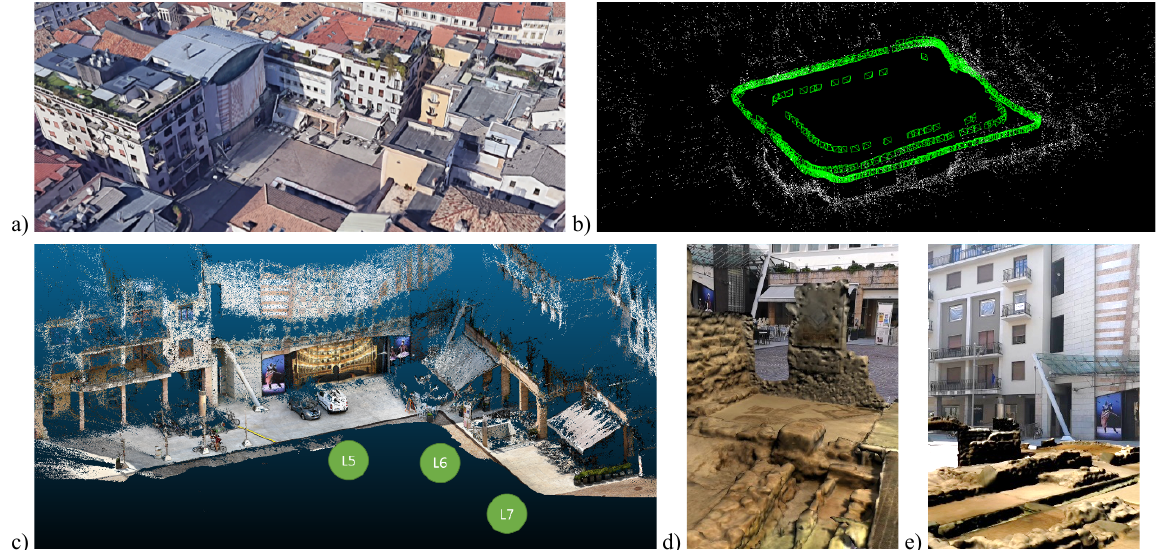
Figure 6 . The square above the Roman city in Trento as seen in Google Earth (a) and the sparse reconstruction from smartphone video sequences (b). Part of the dense point cloud of the area and the positions L i for the localization tests (c). Some views of the MAR application overlaying the 3D digital model of the roman remains to the modern square (d, e).